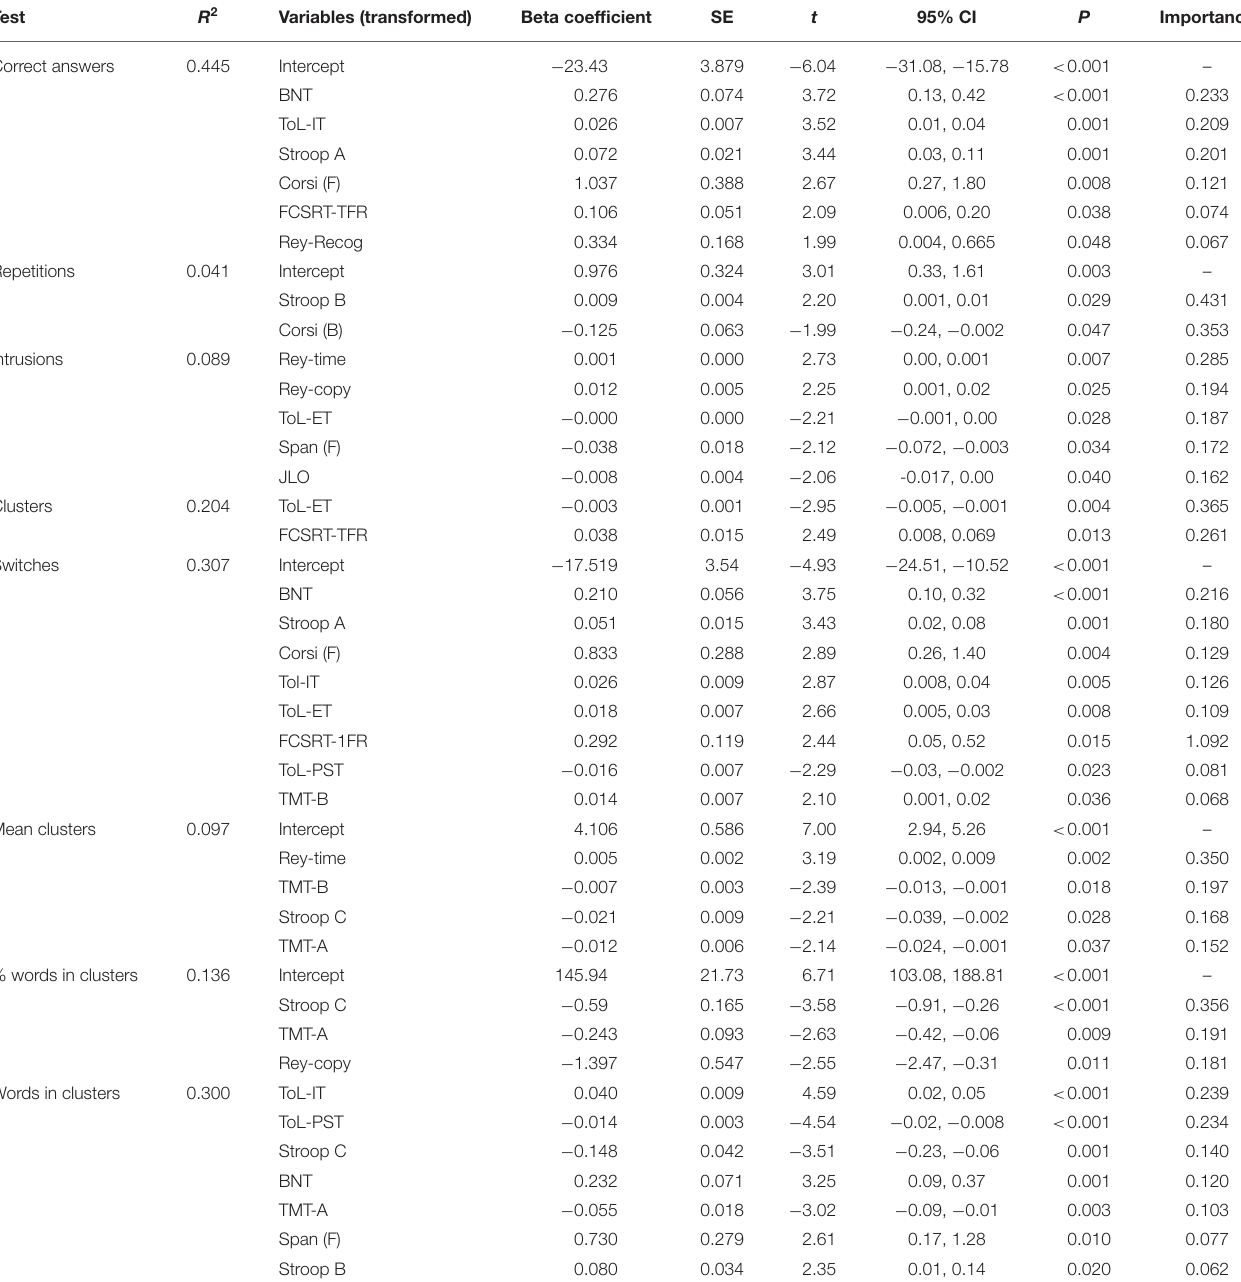
TABLE 4 | Automatic linear modeling assessing the neuropsychological predictors of phonemic fluency